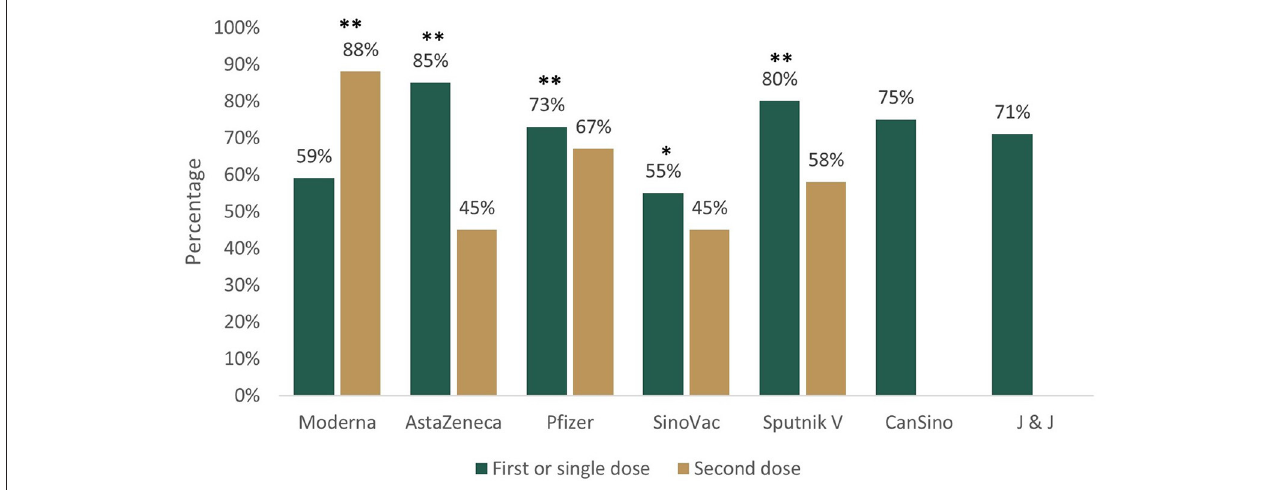
FIGURE 3 | Prevalence of at least one side effect after first/single and second dose of Coronavirus Disease-2019 (COVID-19) vaccines in Mexican population, August to September 2021. * p ≤ 0.05, ** p < 0.001 Z -tests for analyzing the difference between two proportions. Moderna (mRNA-1273), AstraZeneca (ChAdOx1), Pfizer (BNT162b2), Sinovac (CoronaVac), Sputnik V (Gam-COVID-Vac), CanSino (Ad5-nCoV), and J & J (Johnson & Johnson,